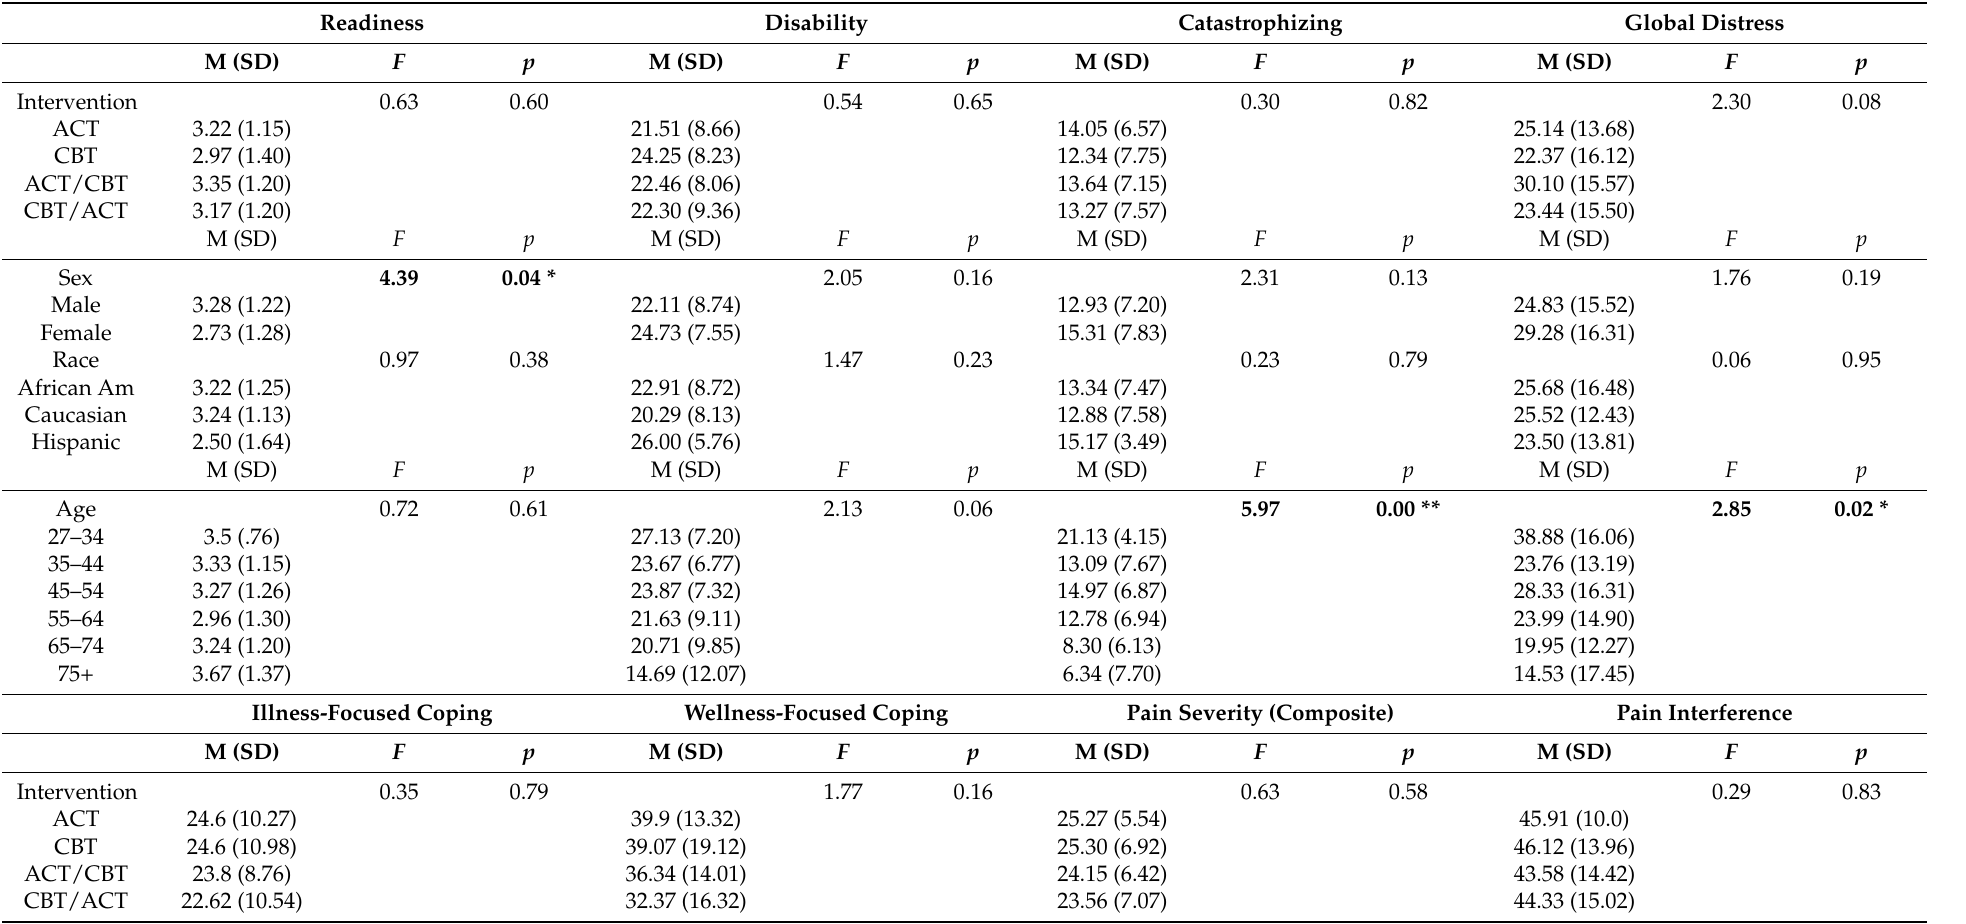
Table 1. Baseline outcome measure scores by patient characteristics ( n =